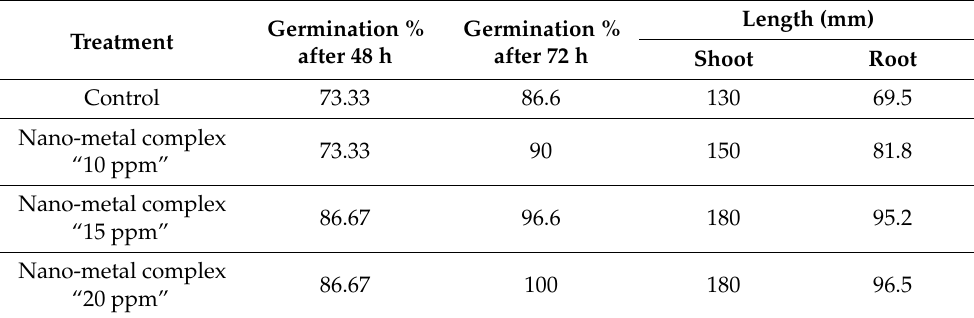
Table 6. Effect of nano-metal complex treatments on germination (%) and root and shoot lengths (mm) of Vicia faba .